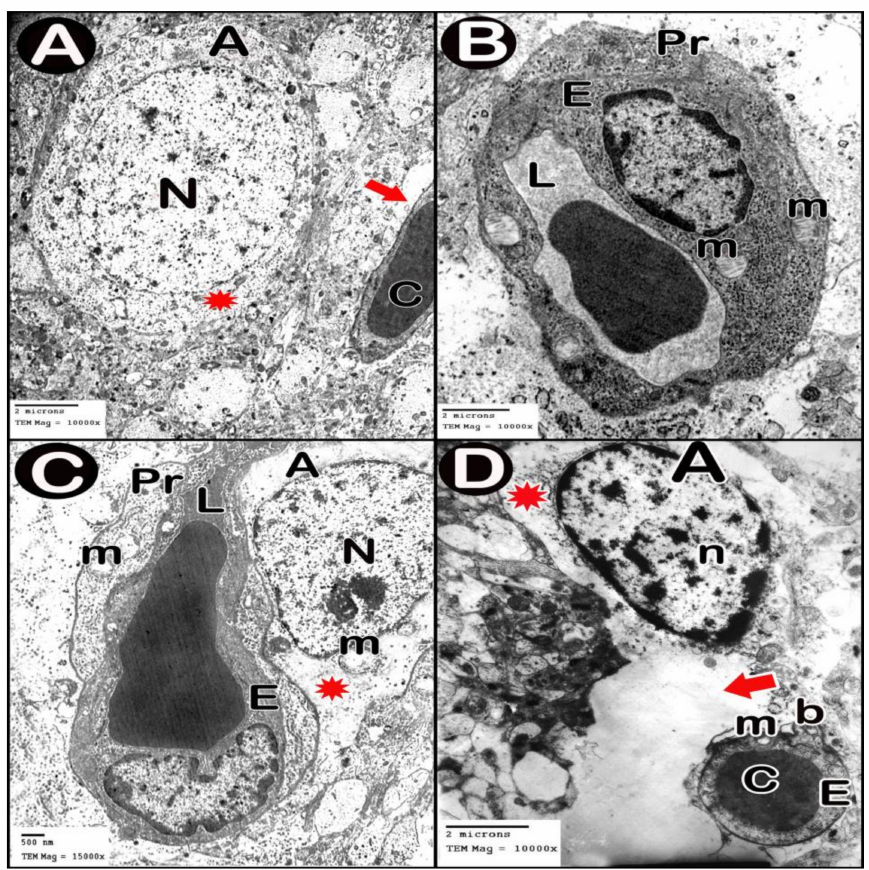
Figure 8. Electron micrographs of Blood brain barrier. ( A , B ) control group. ( C ) low-dose group. ( D ) high-dose group. Astrocyte (A), nucleus (N), cytoplasm (asterisk), blood capillary (C) separated by perivascular spaces (thick arrow), lumen of blood capillary (L), endothelial lining (E), mitochondria (m), pericyte cytoplasm (Pr), clumps of heterochromatin within and around the edge of the nucleus (n) and separation of the basement membrane (b).